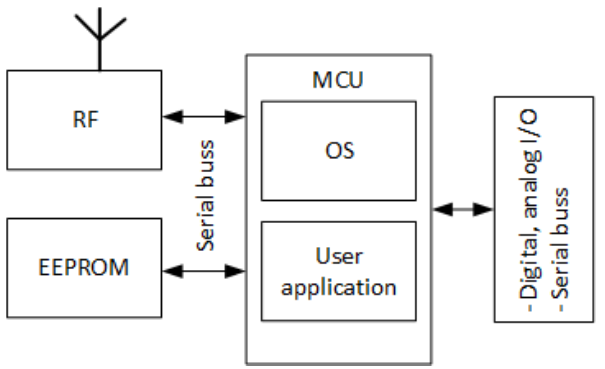
Figure 5. IQRF transceiver module architecture https://www.iqrfalliance.org/technology, (accessed on 4 November